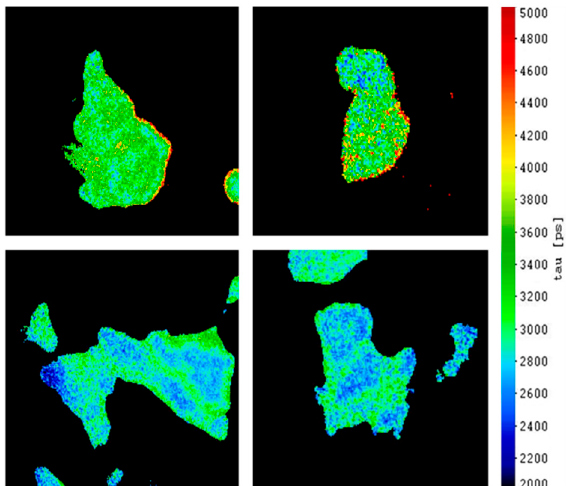
Figure 3. Fluorescence lifetime imaging of EGFR-CFP in HeLa cells upon total internal reflection (TIR) illumination in the absence (top) and in the presence (bottom) of Grb2-YFP including a scale in picoseconds (excitation wavelength: 420–440 nm; detection range: 450–490 nm; image size: 100 μ m × 100 µ m each).